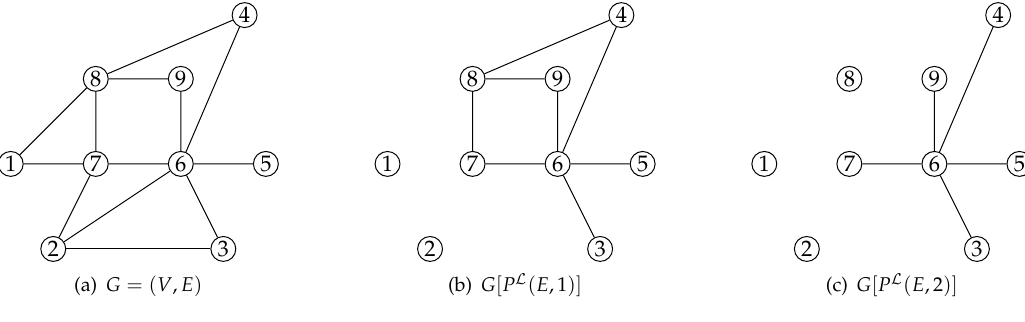
Figure 1. Graph G = ( V , E ) , the induced subgraphs G [ P L ( E ,1 )] , and G [ P L ( E ,2 )] for (see Example